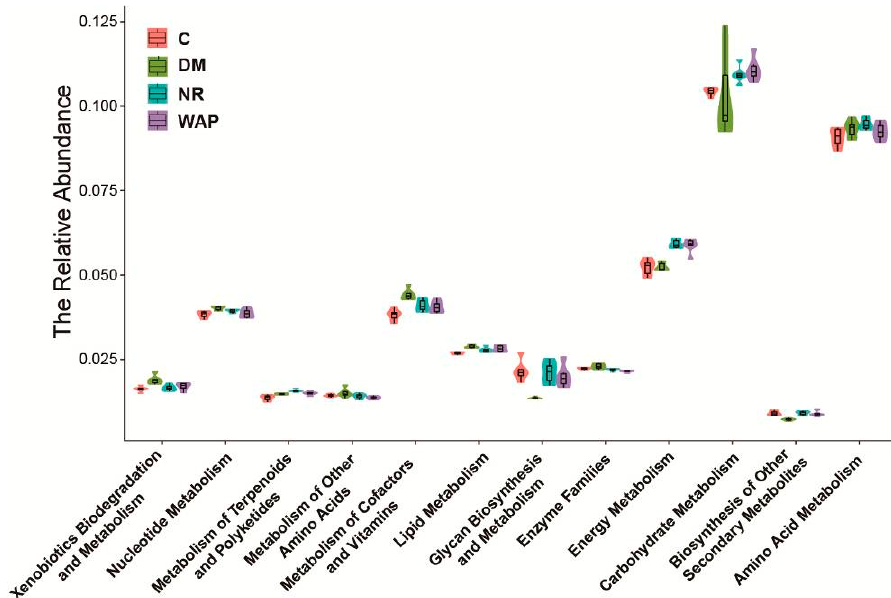
Figure 7. Effect of WAP on metabolic processes. C, control group; DM, antibiotic-associated diarrhea group; NR, natural recovery group; and WAP, Astragalus polysaccharides group.